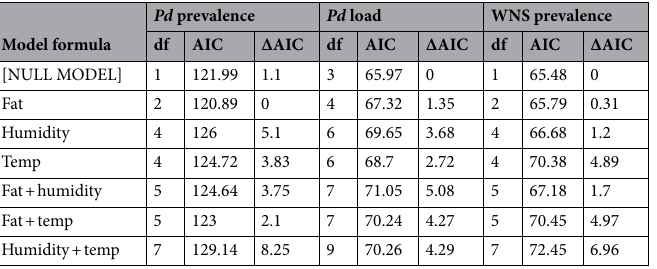
Table 2. Model selection results for model comparisons of humidity and temperature and pre-hibernation fat mass on Pd prevalence, Pd load, and WNS prevalence.